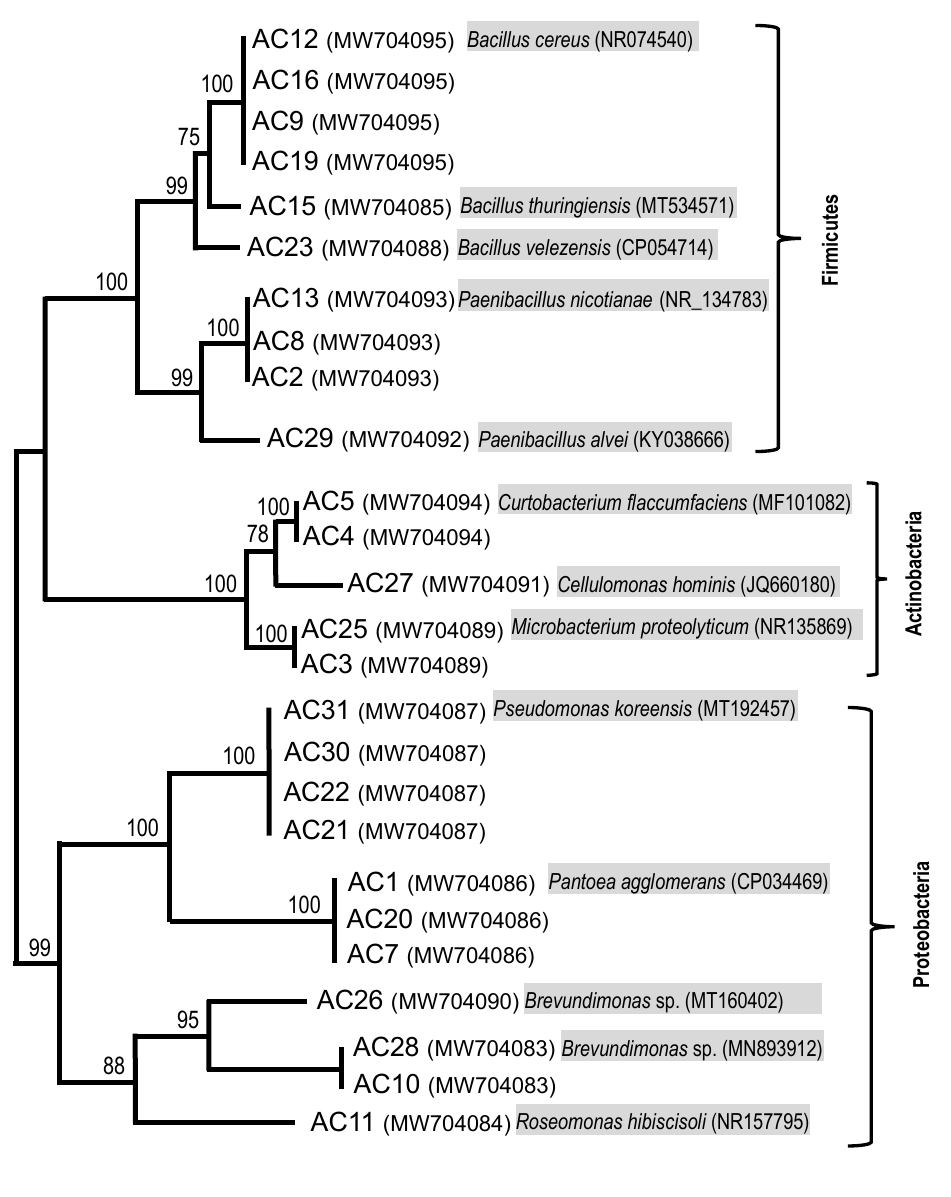
Figure 1. Maximum likelihood phylogenetic tree based on partial sequences of the 16S rRNA gene of the 26 isolates from the leaves of field-grown soybean leaves. We used 13 unique species to create a bacterial consortium. Numbers above the nodes represent the maximum likelihood of bootstrap support above 70%. Numbers in the parenthesis next to the name of the isolate represent the GenBank accession number. The most closely related organism identified based on the NCBI blast search were also reported next to the name of the isolated strain (shaded in gray). Clustering at the phylum level was shown on the right.